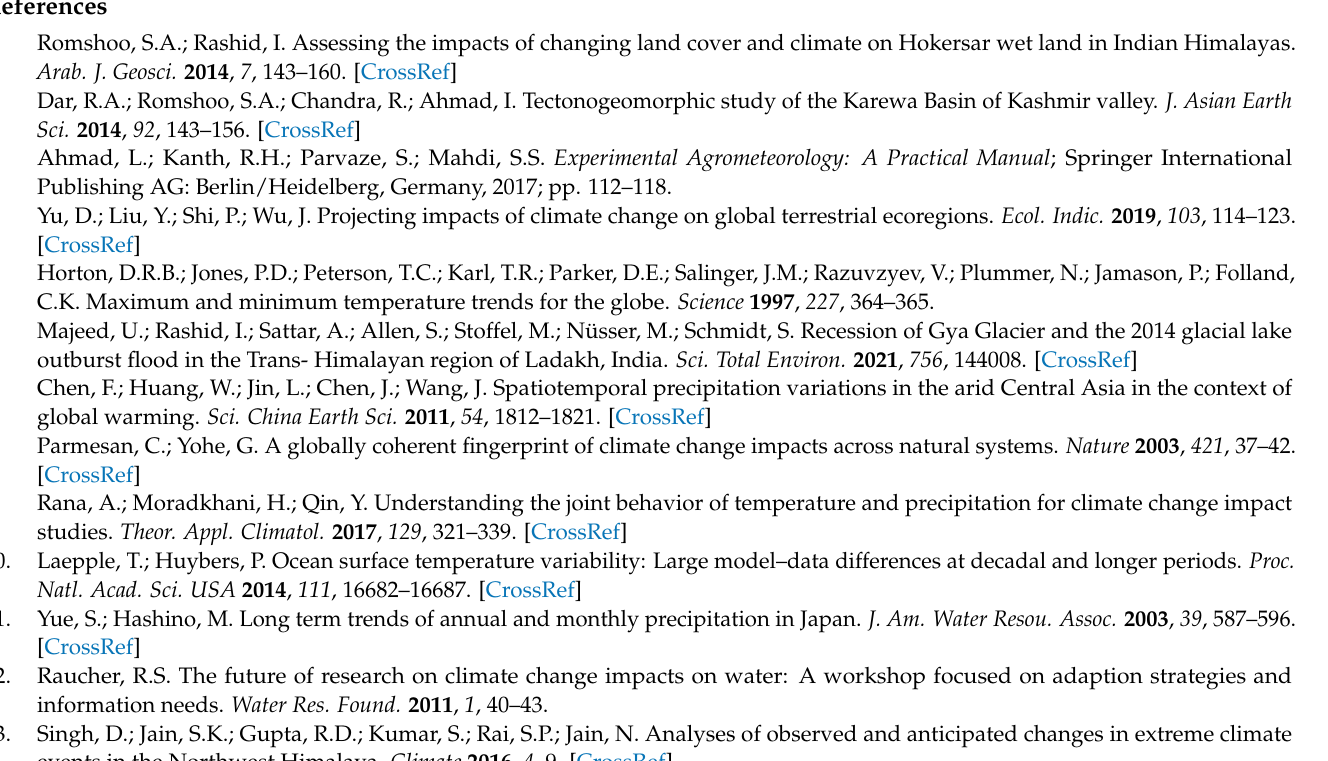
temperature; Table S2. Statistical analysis of minimum temperature; Table S3. Statistical analysis of rainfall; Figure S1. Residual graph of temperature and rainfall of Shalimar; Figure S2. Residual graph of temperature and rainfall of Qazigund; Figure S3. Residual graph of temperature and rainfall of Pahalgam; Figure S4. Residual graph of temperature and rainfall of Gulmarg; Figure S5. Residual graph of temperature and rainfall of Kupwara; Figure S6. Residual graph of temperature and rainfall of Kokernag; Table S4. Statistical analysis of maximum temperature, Kashmir valley; Figure S7. Residual graph of temperature and rainfall of